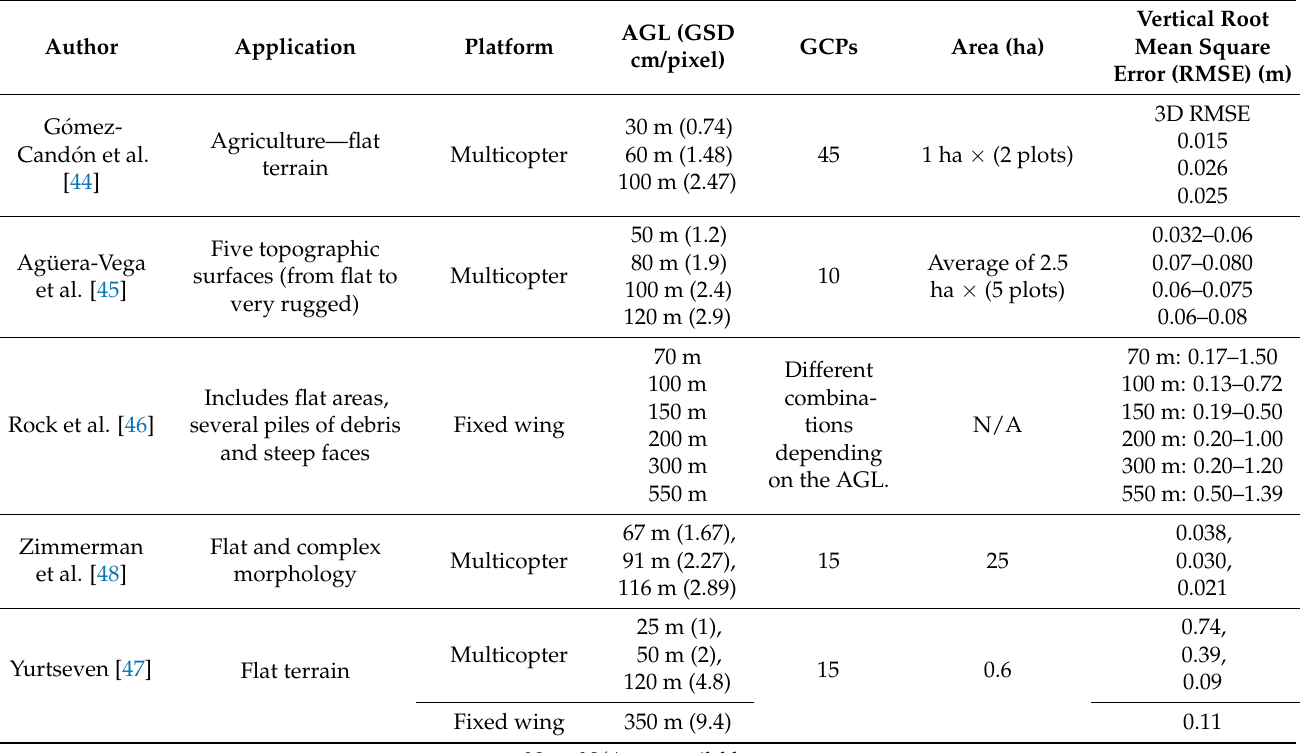
Table 2. Studies where the flight altitude above ground level (AGL) vs. accuracy is analyzed.